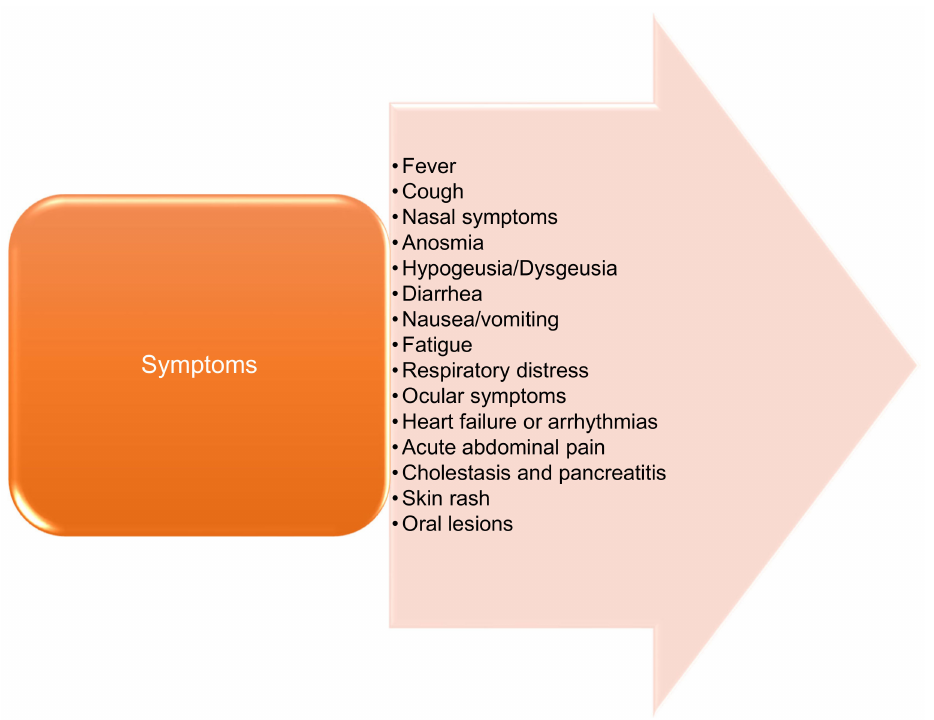
Figure 1. Main symptoms of